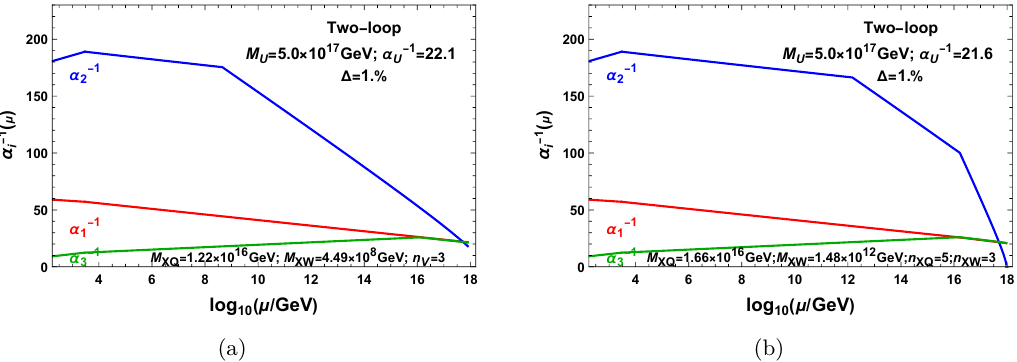
= 1 × 5 and k = 1 . The string-scale gauge coupling relation can be Y 2 3 3